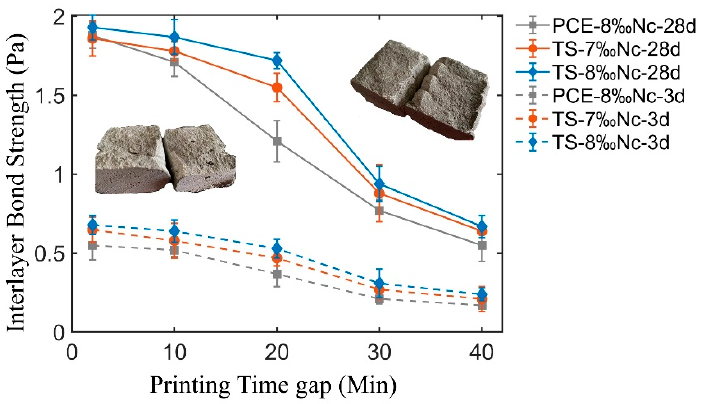
Figure 10. Interlayer bond strength vs. printing time gap of 3D printed mortar with standard cured for 3 days and 28 days. for 3 days and 28